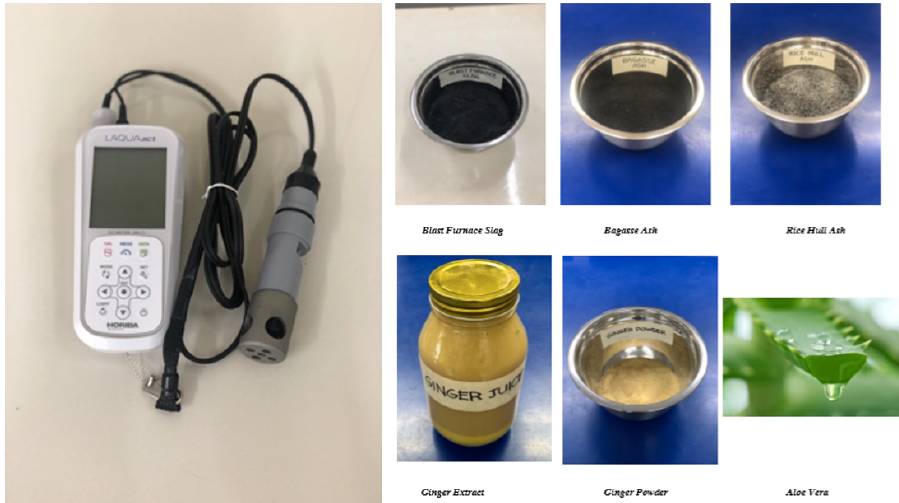
Figure 2. DO meter and sample candidate materials.